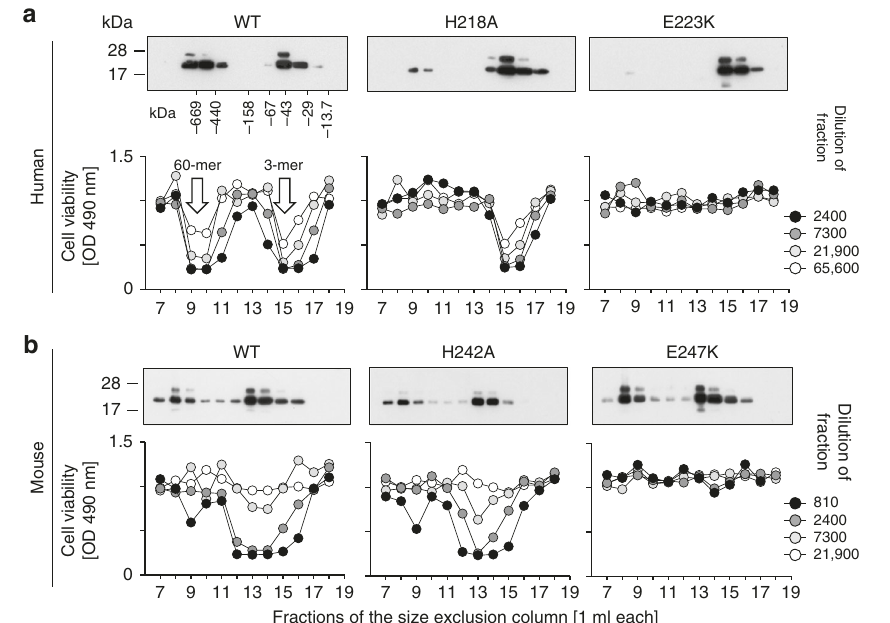
Fig. 2 Flap mutations affecting 60-mer formation: one of them additionally affects activity of BAFF 3-mer. Naturally cleaved, untagged human or mouse BAFF, with or without the indicated mutations in the fl ap, were recovered in supernatant of 293 T cells transiently transfected with plasmids encoding the full length wild type (WT) or mutant BAFF. Concentrated supernatants were fractionated by size-exclusion chromatography and fractions analyzed for the presence of BAFF by western blot using anti-human or anti-mouse BAFF antibodies, and for the activity of BAFF at the indicated dilutions of fractions using a hBAFFR:Fas reporter cell line that undergoes Fas-mediated killing upon stimulation of the chimeric receptor by BAFF. a Analysis of human BAFF WT and mutants. White arrows points at fractions with peak activity of BAFF 3-mer and 60-mer, as indicated. b Analysis of mouse BAFF WT and mutants. The experiment was performed twice for human BAFF and thrice for mouse